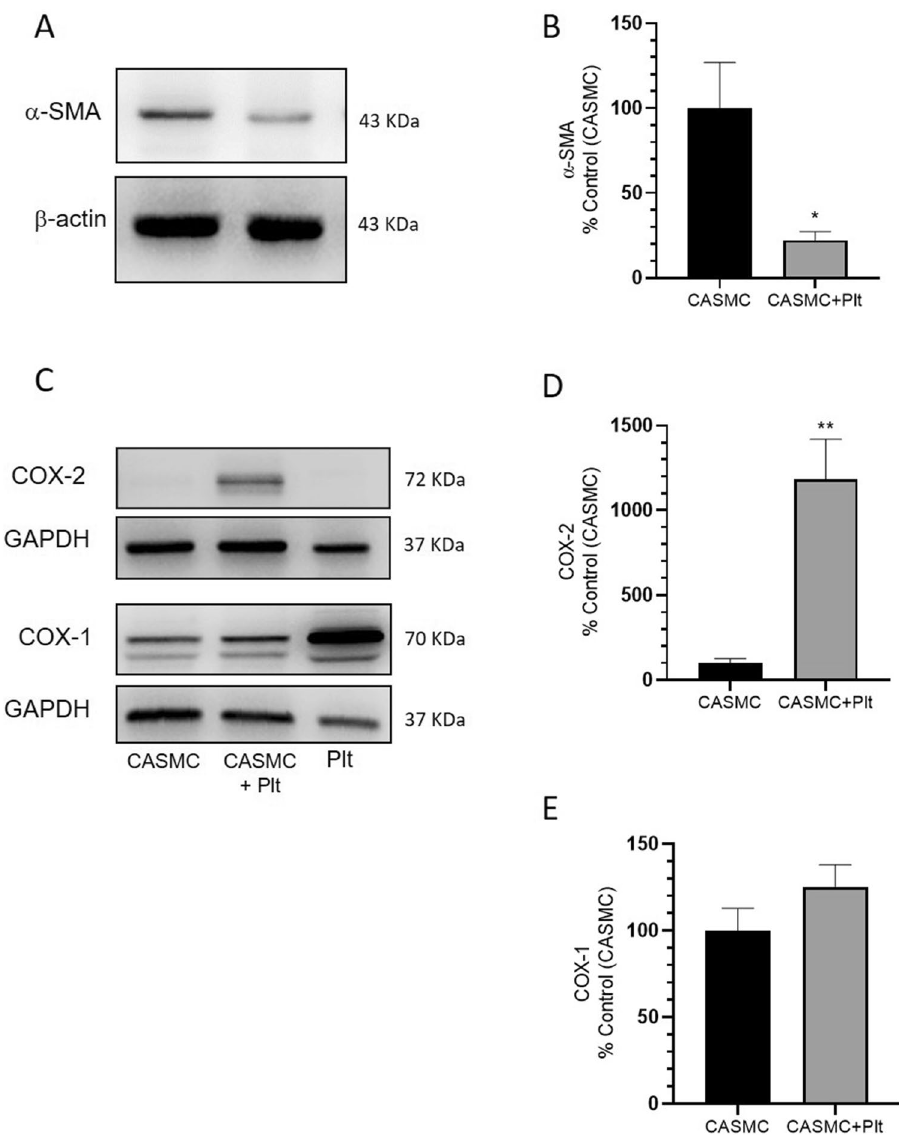
Figure 2. Effects of platelets on α-SMA, COX-2, and COX-1 protein levels in CASMC cultured alone or cocultured with platelets. ( A ) α-SMA levels were evaluated by Western blot in CASMC cultured alone or cocultured with platelets for 24 h; ( B ) the protein bands were quantified, and the optical density (OD) was calculated using laser densitometry and normalized to the OD of β-actin; data are reported as % of control (CASMC cultured alone), mean ± SEM, n = 5 (separate experiments); * P < 0.05 versus CASMC cultured alone (using Student’s t-test ) . ( C – E ) COX-2 and COX-1 levels were evaluated by Western blot in platelets (Plt) or CASMC cultured alone or in CASMC cocultured with platelets (CASMC + Plt) for 20 h; ( D , E ) the protein bands were quantified and OD was calculated and normalized to the OD of GAPDH, data are reported as % of control (CASMC cultured alone), mean ± SEM, n = 5 and n = 3 (separate experiments), respectively; ( D ) ** P < 0.01 versus CASMC cultured alone (using Student’s t-test )